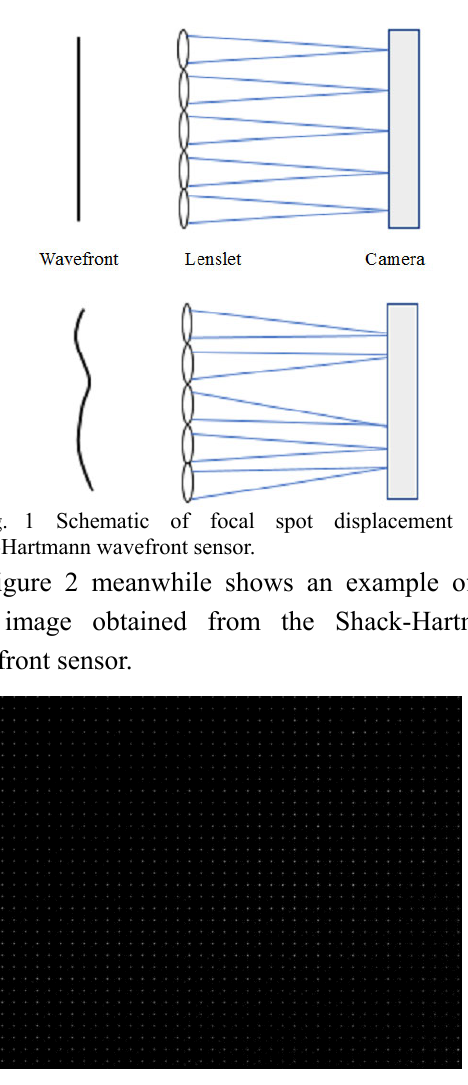
Fig. 2 Spot image from the Shack-Hartmann wavefront